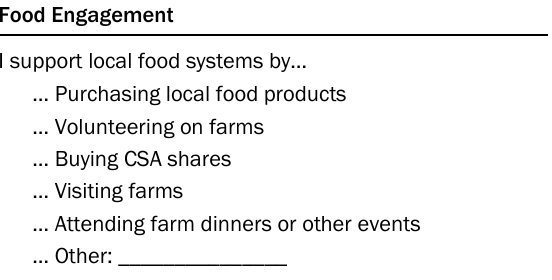
Table 1. Questions Included in the Food Engagement